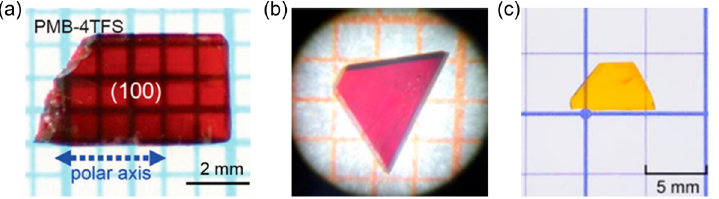
Figure 19. Crystal photos of ( a ) PMB-4TFS [27], ( b ) HDB-T [48], and ( c ) OHI-T [53] grown using slow evaporation .